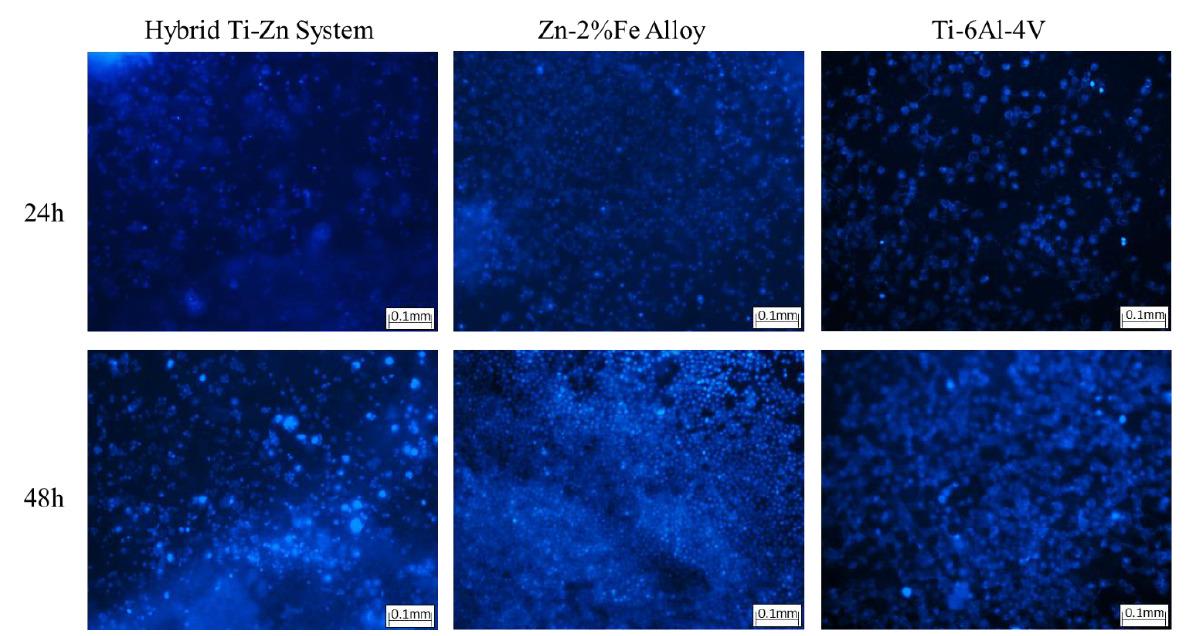
Figure 7. Fluorescence images of NucBlue-stained 4T1 cells attached to the surface of the corresponding alloys after 24 and 48 h of incubation. Scalebar = 100 μm.